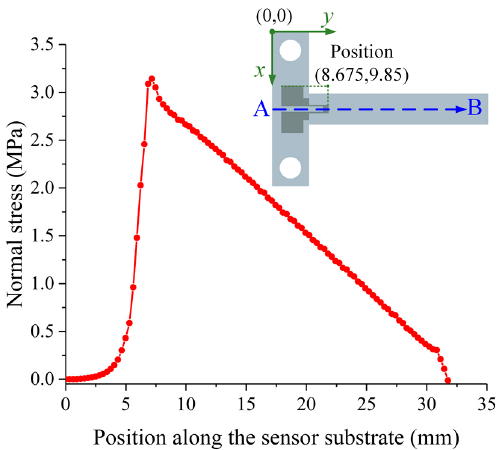
Figure 5. The normal stress distribution along the path A to B on the sensor substrate and the position of the strain gauge.